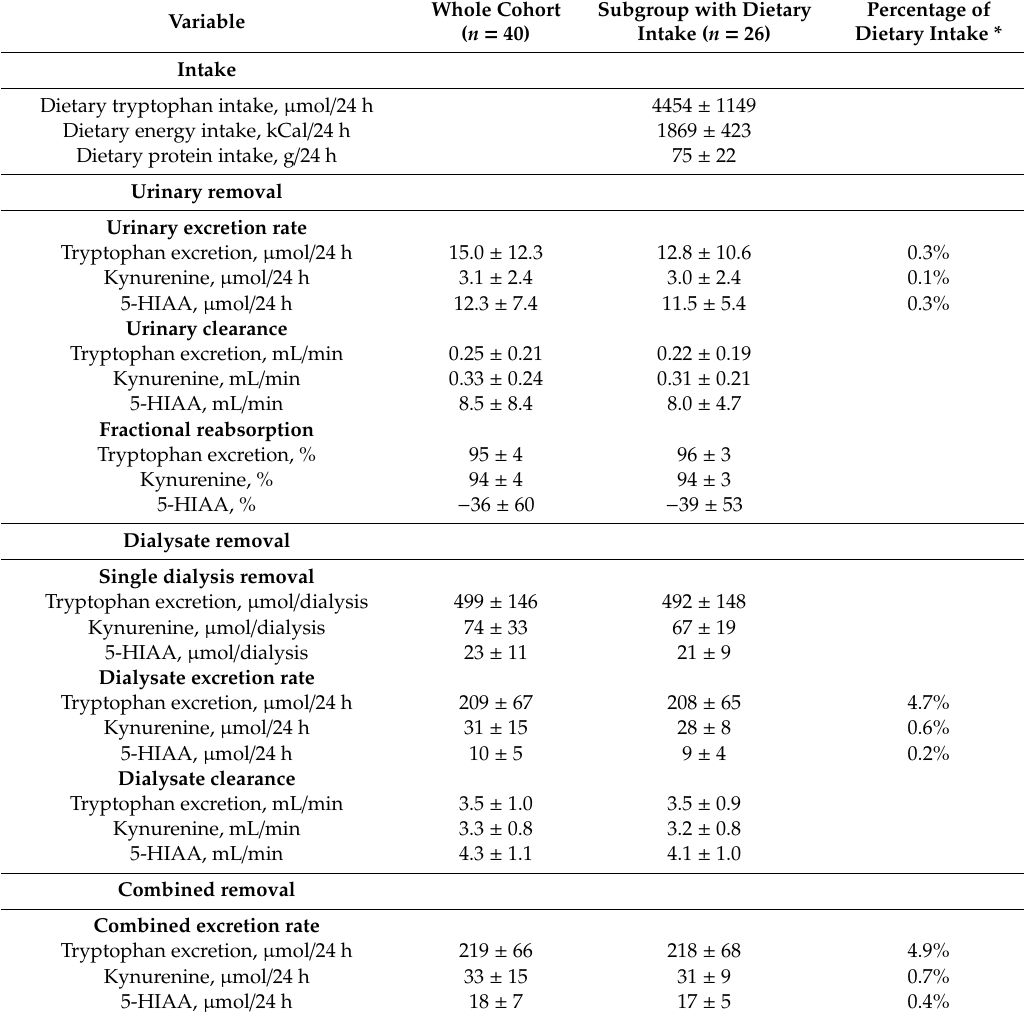
Table 3. Intakes and excretions in the whole cohort and a subgroup who completed dietary